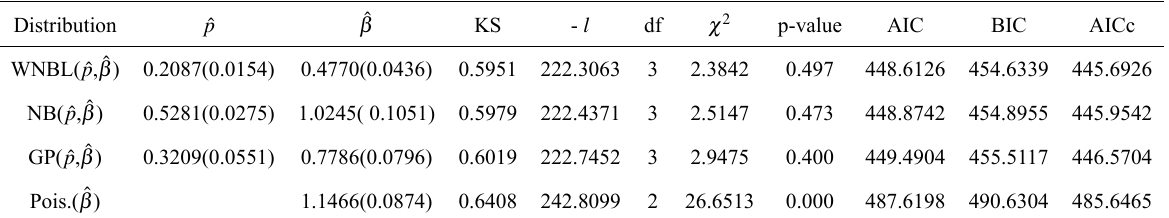
Tests Summary for data set I.